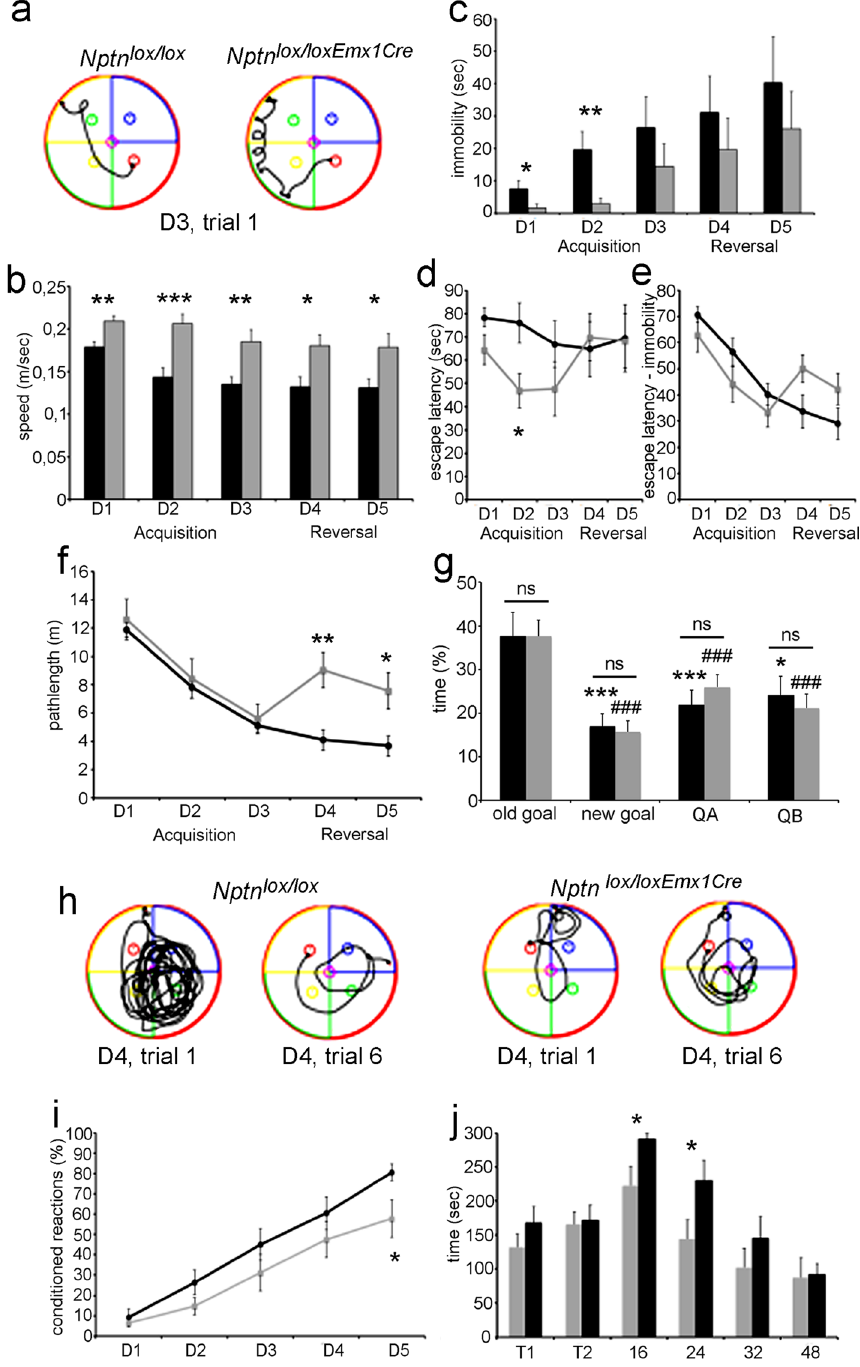
Figure 2. Behavioral deficits in Nptn lox/loxEmx1Cre mice. Nptn lox/loxEmx1Cre (n = 11, black bars and lines) and Nptn lox/lox (n = 12, grey) mice were examined ( a – h ) in the water maze, ( i ) in the shuttle box, ( j ) and on the rota-rod. ( a ) Representative examples of tracks recorded during acquisition (day3, 1st trial) showing frequent re- initiation of swimming by Nptn lox/loxEmx1Cre mice. ( b ) Average speed, ( c ) times of immobility, ( d ) escape latency, ( e ) escape latency corrected for times of immobility, and ( f ) path length are displayed. ( g ) Quadrant preference during the first 2 trials after platform reversal at day 4. QA, QB quadrants without platform. The old goal quadrant was significantly preferred compared to the other quadrants irrespective of the genotype of the mice. ( h ) Representative examples of tracks recorded immediately (day4, trial1) after platform reversal and after training (day4, trial6) for the new platform position. Nptn lox/lox mice initially persist on the old goal (trial1) and develop quickly a new spatial strategy (trial 6), whereas Nptn lox/loxEmx1Cre mice display a serial circular strategy. ( i ) The percentage of conditioned reactions in the shuttle box two-way active avoidance paradigm, ( j ) and the time staying on the rota-rod are displayed. Data are mean ± SEM. One-way ANOVA, one, two, and three asterisks indicate P < 0.05, P < 0.01, and P < 0.001, respectively, three # indicate P <